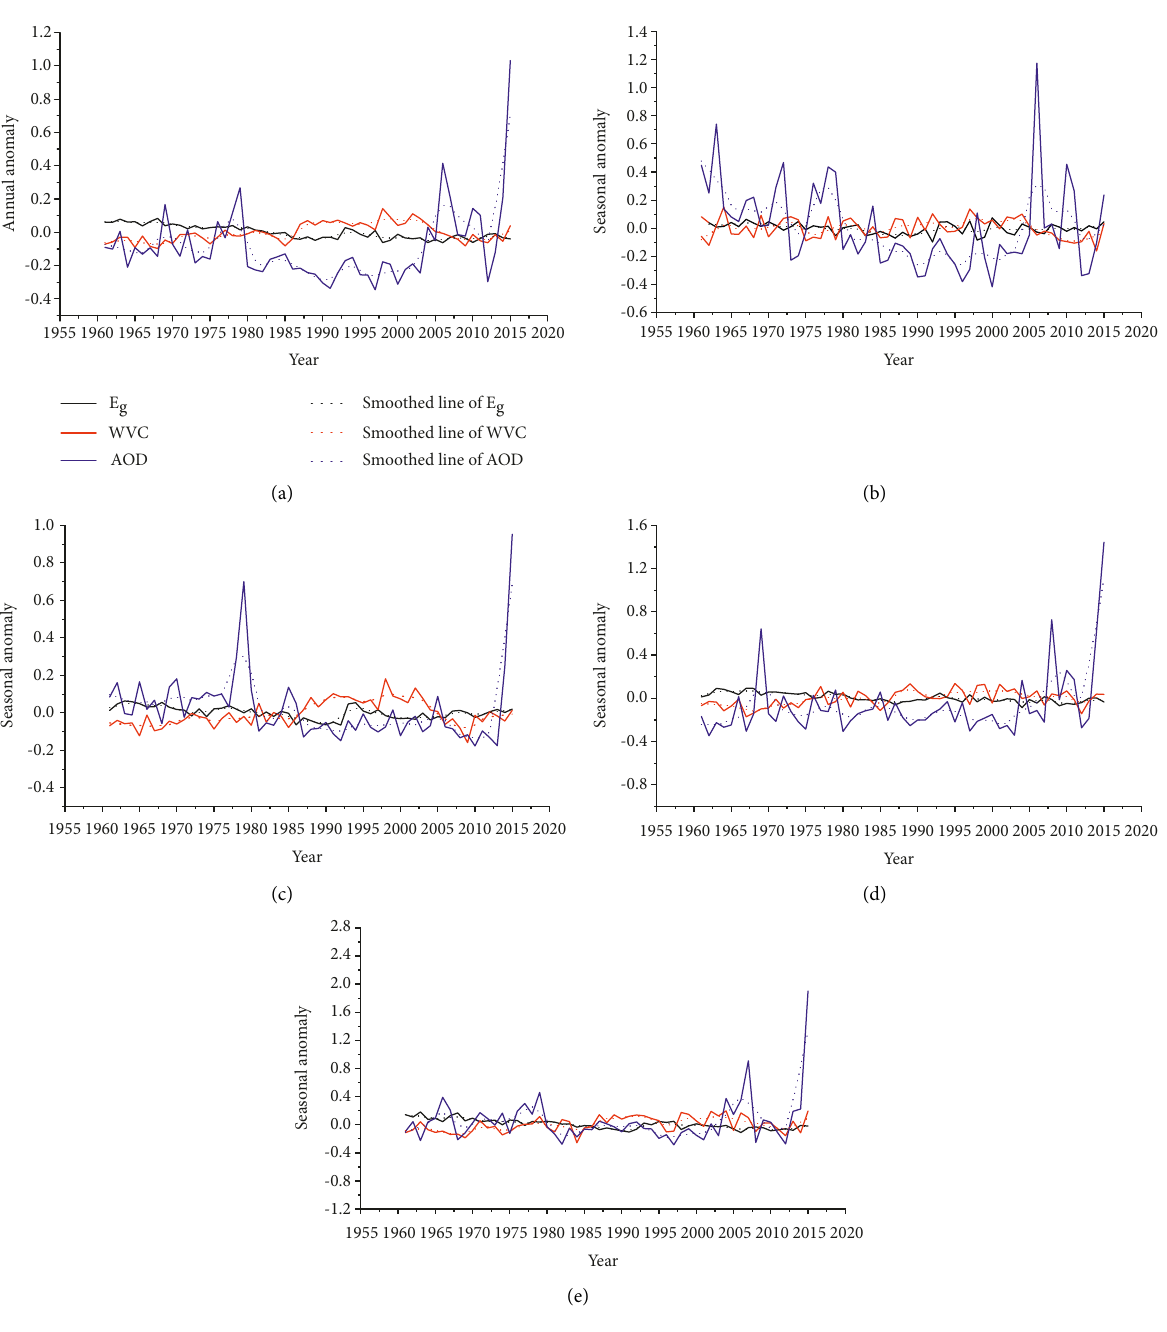
Smoothed line of Eg Smoothed line of WVC